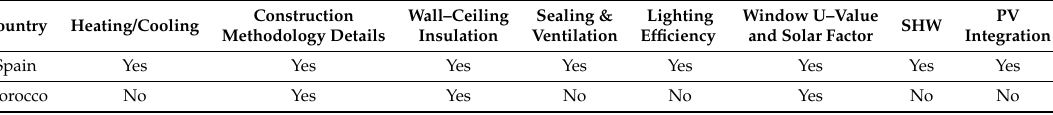
Table 3. Spanish and Moroccan legislation on energy efficiency: variables under consideration. Country